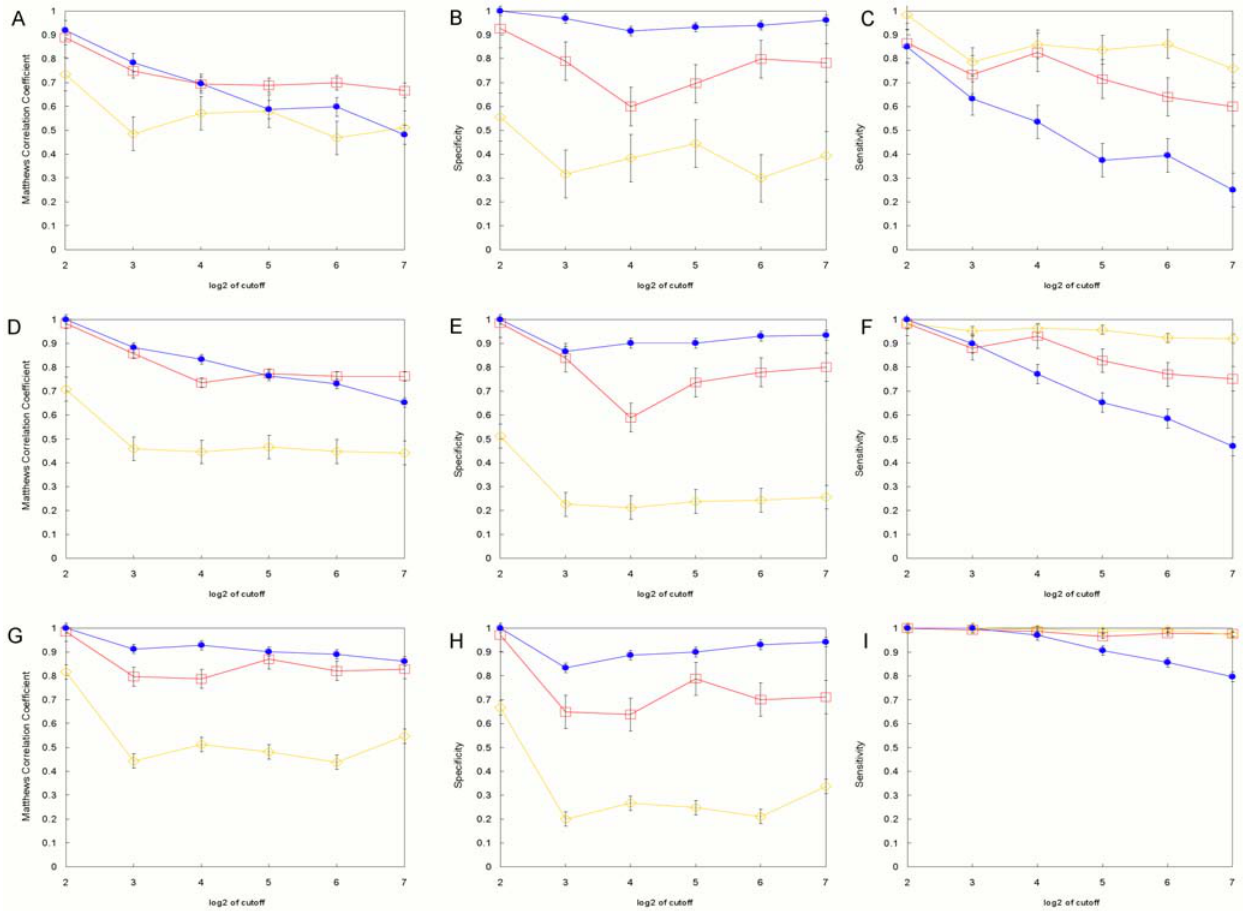
Figure 4. Performance of the position weight matrix models with Boltzmann sampling. A–C. Alignments containing 20 sites. D–F. Alignments containing 50 sites. G–I. Alignments containing 200 sites. The log-odds, Match, and quadratic programming results are denoted by the red open-square, yellow open-diamond, and blue filled-oval markers respectively. Each data point is the mean of five replicates. Error bars denote the standard deviation of the mean.